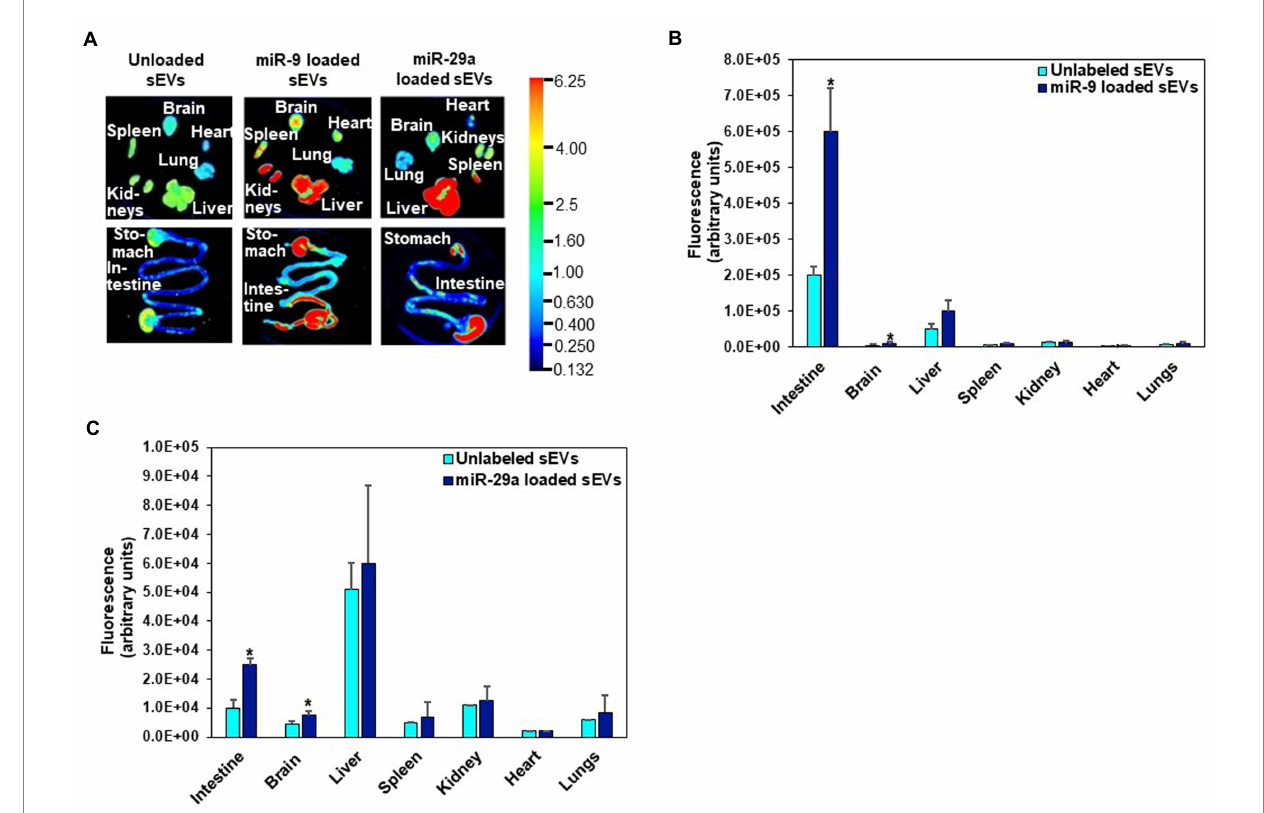
FIGURE 5 Distribution of egg sEVs loaded with IRDye-labeled miR-9 or miR-29a and delivered by oral gavage in C57BL/6 J mice (A) . Densitometric analysis of background-normalized fluorescence in intestine, brain, liver, spleen, kidney, heart, and lungs showing accumulation of miR-9 (B) and miR-29a (C) . Values are mean ± SEM ( n = 3). Data were analyzed by Mann–Whitney U test (*Value of p < 0.05). Fluorescence is reported as arbitrary units (au) (B, C) . Data were normalized by using the fluorescence from tissue-free sections in the dish.